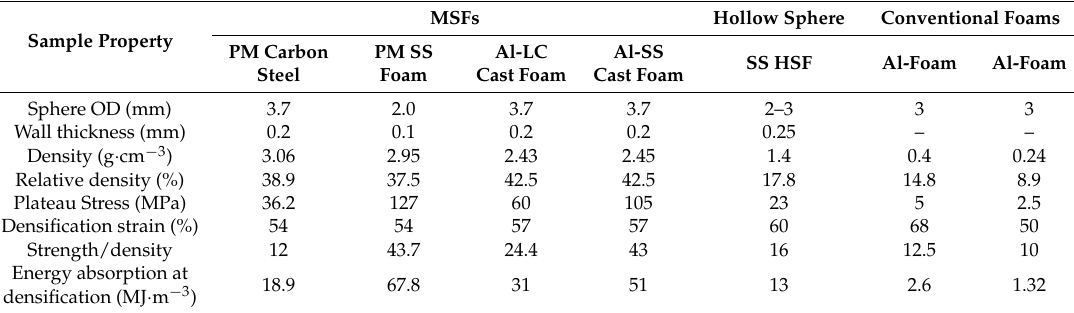
Table 6. Properties of composite metal foams with conventional metal foams